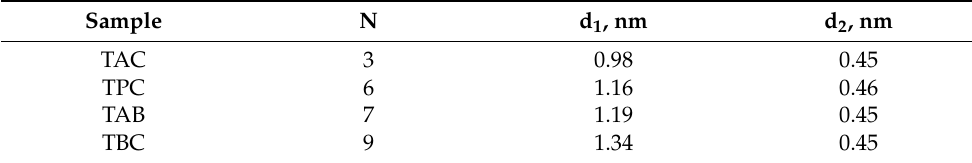
Table 2. Parameters of mesomorphous structure of cellulose esters.